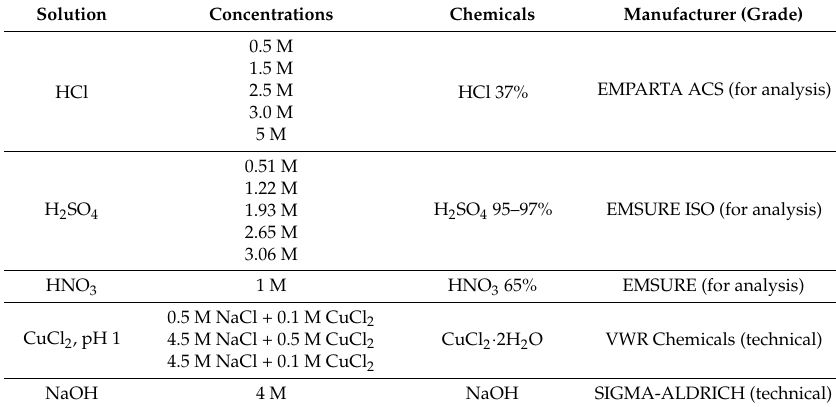
Table 3. Solutions used in the leaching tests.